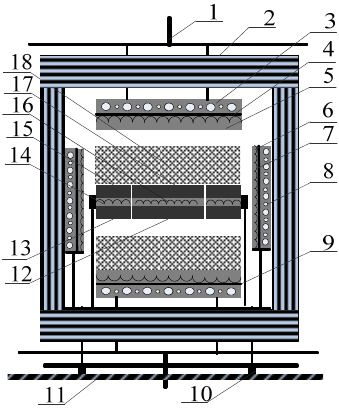
Figure 2. Schematic diagram of thermal conductivity test bench. 1. Loading structure; 2. Multi-layer insulation structure; 3. Upper shroud plate; 4. Upper heat resistance layer; 5. Upper heating cold plate; 6. Secondary protective heat plate; 7. Surrounding heat insulation layer; 8. Surrounding shroud; 9. Lower cold plate assembly; 10. Internal support; 11. Vacuum chamber bottom plate; 12. Lower metering temperature measurement plate; 13. Lower protective temperature measurement plate; 14. Protective heating plate; 15. Upper metering heating plate; 16. Heat plate; 17. Upper metering temperature measuring plate; 18.Test sample.